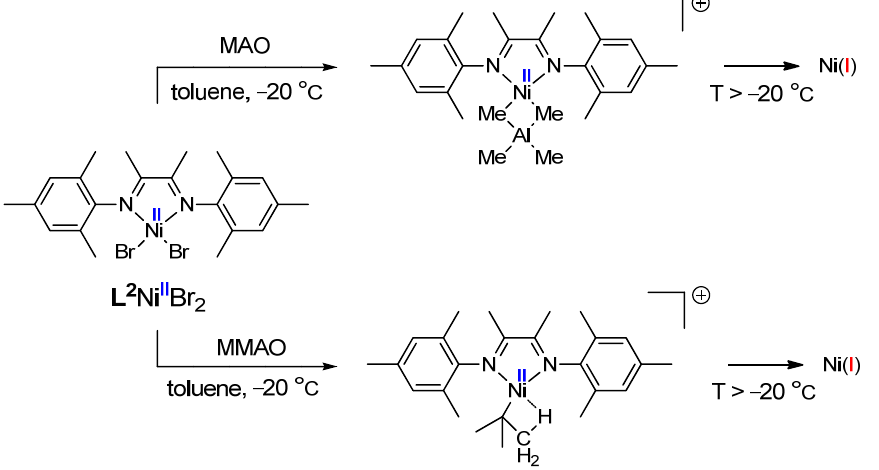
Figure 2. Structures of [( L 4 Ni I Br) 2 MgBr 2 (THF) 2 ] and [( L 4 Ni I Br) 2 ].